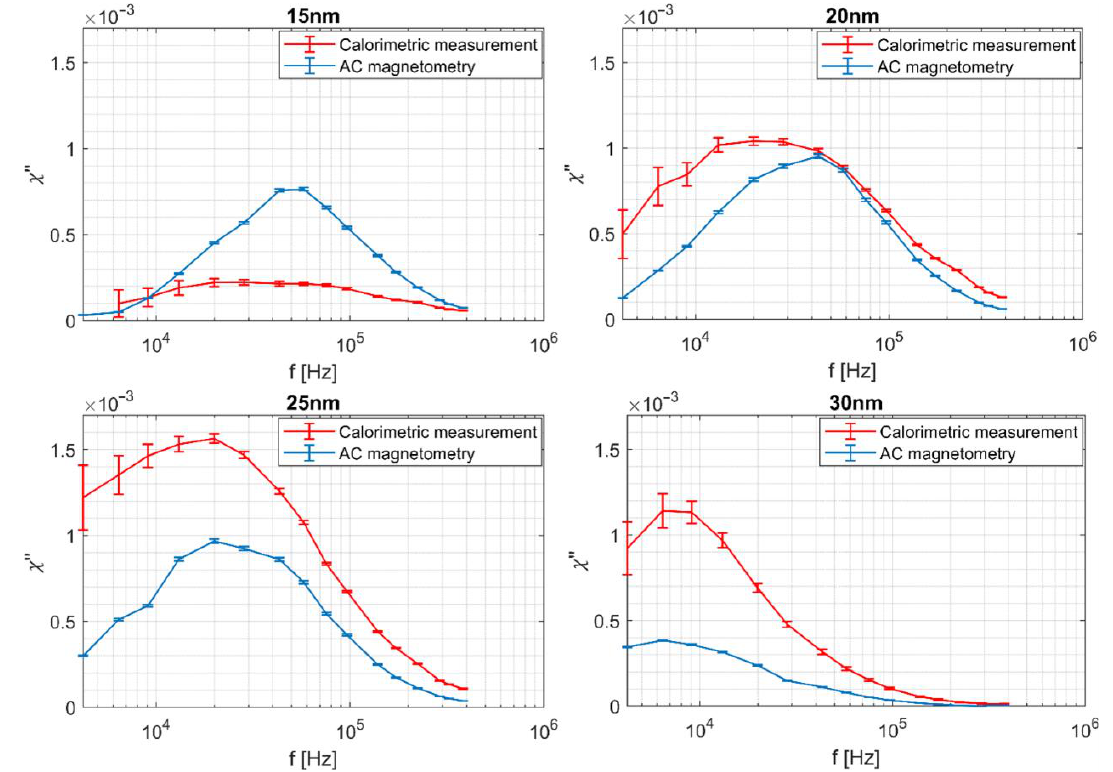
Figure 7. The imaginary part of complex magnetic susceptibility for different nanoparticle diameters calculated from calorimetric measurements (red line) and AC magnetometry (blue line).